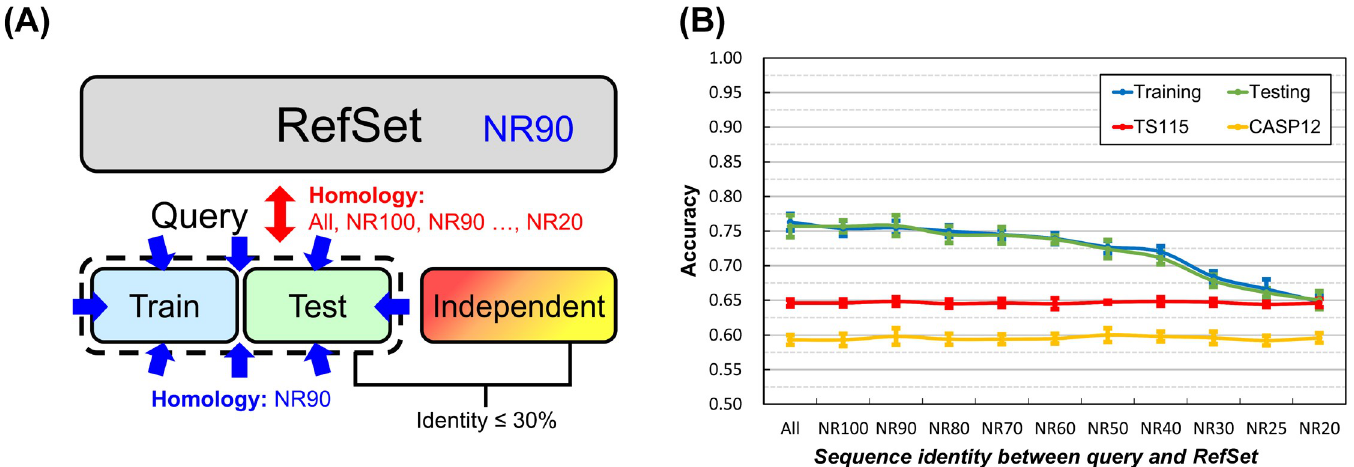
Fig 4. Effects of the homology between query and PSSM reference datasets on the accuracy of secondary structure prediction. (A) The layout of datasets. Only one reference dataset containing 10,000 proteins with < 90% sequence identities was used. To ensure that there would be sufficient proteins to sustain the size of training and testing query sets used in this study, i . e ., 250 for each, the sequence identity cutoff between and within these query sets was fixed at 90%. (B) Accuracy of SSP obtained with training/testing query sets sharing decreasing sequence identities with the PSSM reference dataset. As expected, the homology between the query sets for training/ testing and the PSSM reference dataset greatly influenced the extent of overfitting. The same influence was observed with the SOV measure (S4 Fig). To our knowledge, most SSP studies had not yet paid attention to the homology reduction between query and reference datasets, which might have led to overestimated accuracies. See Discussion for more